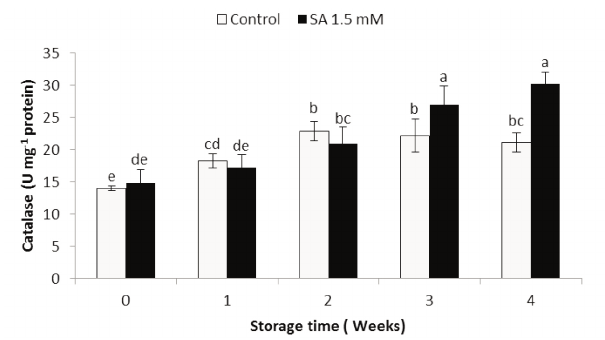
Fig. 8 - CAT activity of peach fruits treated with preharvest SA at 1.5 mM stored at 1±0.5°C for up to 28 days. Data shown are mean ± standard deviation of three replicate (n = 3).